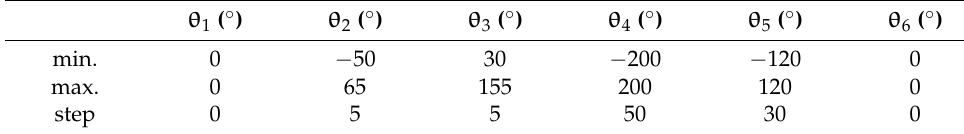
Table 3. Limit values and step sizes for discrete rotations of the robot